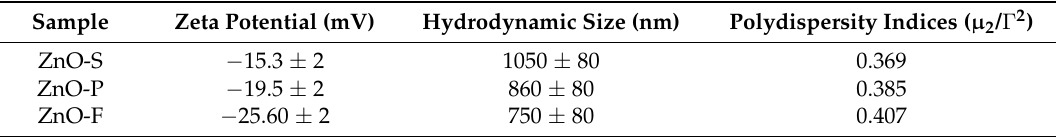
Table 2. Colloidal properties of ZnO-S, ZnO-P and ZnO-F.